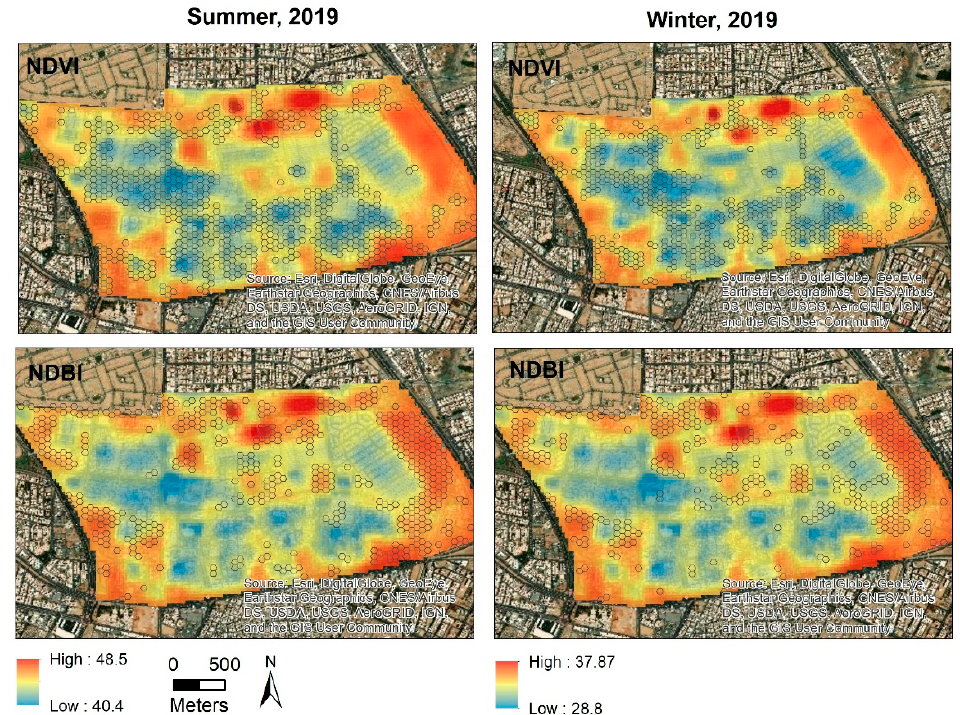
Figure 5. Hexagons (depicted in gray) represent areas (hexagons) that exhibit the highest using the normalized difference vegetation index (NDVI) and the normalized difference built-up index (NDBI) values in the summer (an average value above 0.115 and 0.043, respectively) and winter (an average value above 0.136 and 0.049, respectively), 2019. Units are in degrees Celsius (°C).